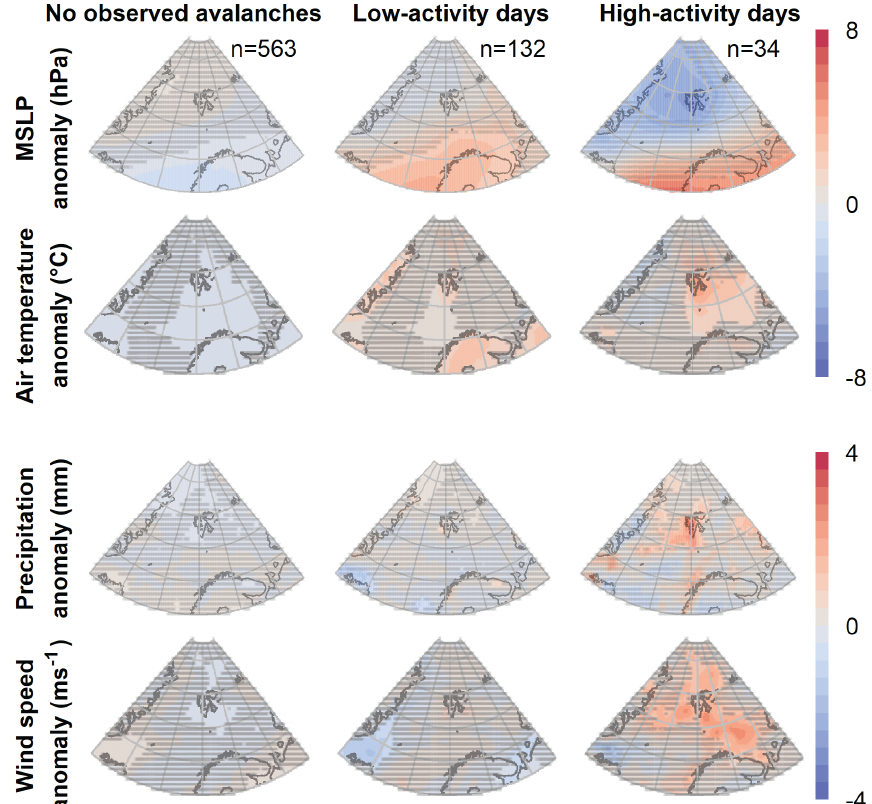
Figure 5. Composite anomaly maps for the meteorological parameters investigated in this study by the daily avalanche activity type classi- fication. Anomalies represent the departure from mean winter conditions (December–May, 2016–2020; see Appendix 1) for the composite mean from daily avalanche activity type and parameter combination. Anomalies that are not statistically significant from mean winter con- ditions are indicated with dense